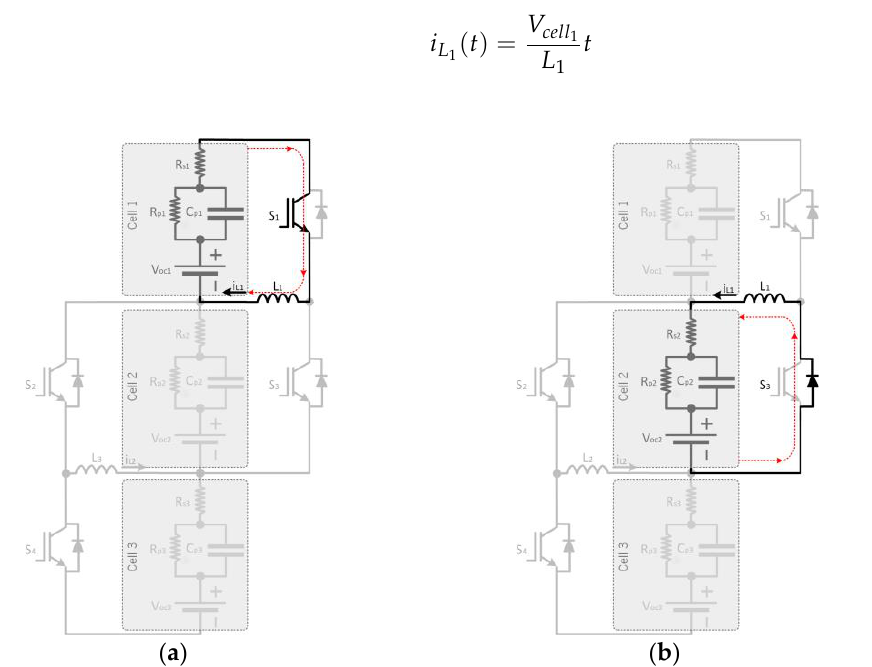
Figure 13. Operating modes of the SwI converter: ( a ) discharging of cell 1; ( b ) charging of cell 2.